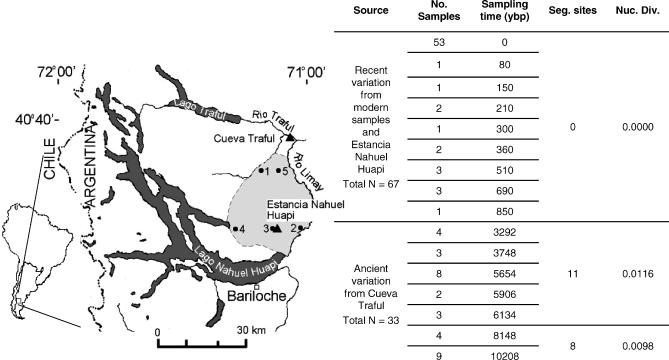
Map of Sampling Sites and Modern Range of C. sociabilis with Table of Temporal SamplingListed are number of samples per sampling time and observed values for segregating sites and nucleotide diversity used in the bottleneck model. Numbers on map indicate locations of modern populations [8].